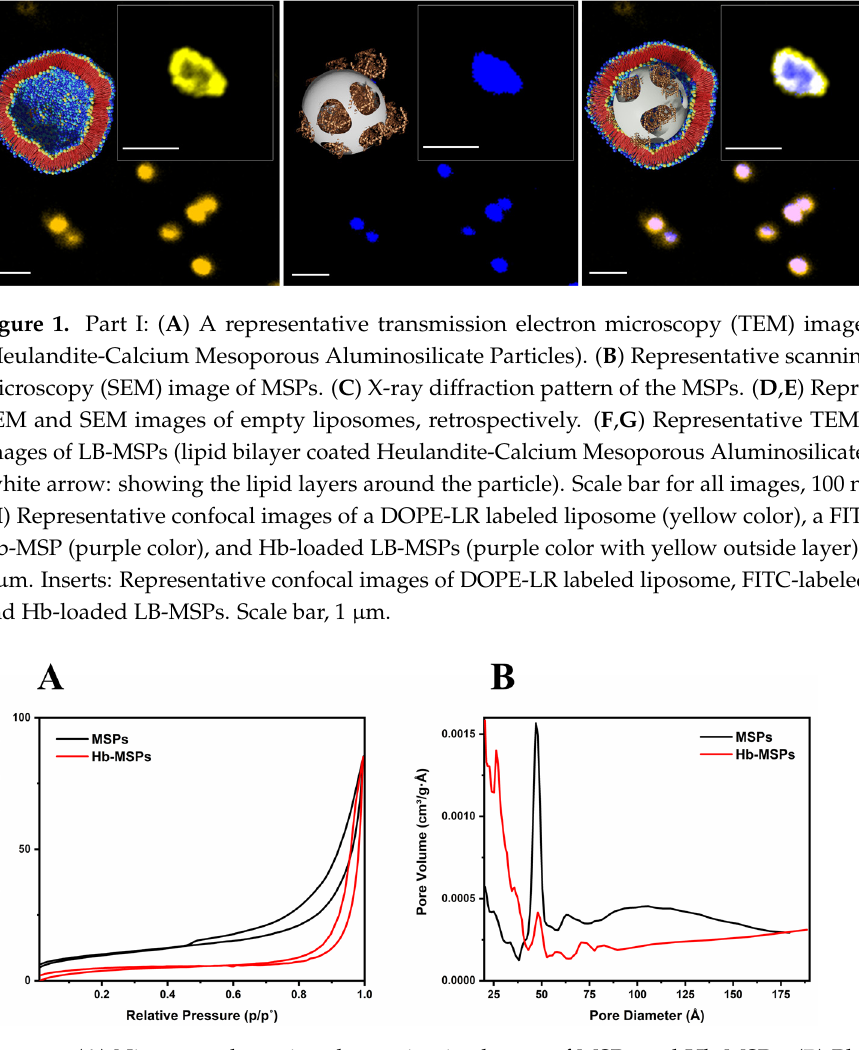
Figure 1. Part I: ( A ) A representative transmission electron microscopy (TEM) image of MSPs (Heulandite-Calcium Mesoporous Aluminosilicate Particles). ( B ) Representative scanning electron microscopy (SEM) image of MSPs. ( C ) X-ray diffraction pattern of the MSPs. ( D , E ) Representative TEM and SEM images of empty liposomes, retrospectively. ( F , G ) Representative TEM and SEM images of LB-MSPs (lipid bilayer coated Heulandite-Calcium Mesoporous Aluminosilicate Particles) (white arrow: showing the lipid layers around the particle). Scale bar for all images, 100 nm. Part II: ( H ) Representative confocal images of a DOPE-LR labeled liposome (yellow color), a FITC-labeled Hb-MSP (purple color), and Hb-loaded LB-MSPs (purple color with yellow outside layer). Scale bar, 2 µm. Inserts: Representative confocal images of DOPE-LR labeled liposome, FITC- labeled Hb-MSP and Hb-loaded LB-MSPs. Scale bar, 1 µm.